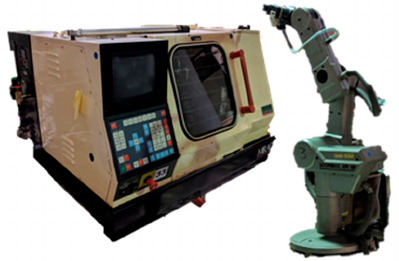
Figure 6. Lathe machine and the robotic arm.